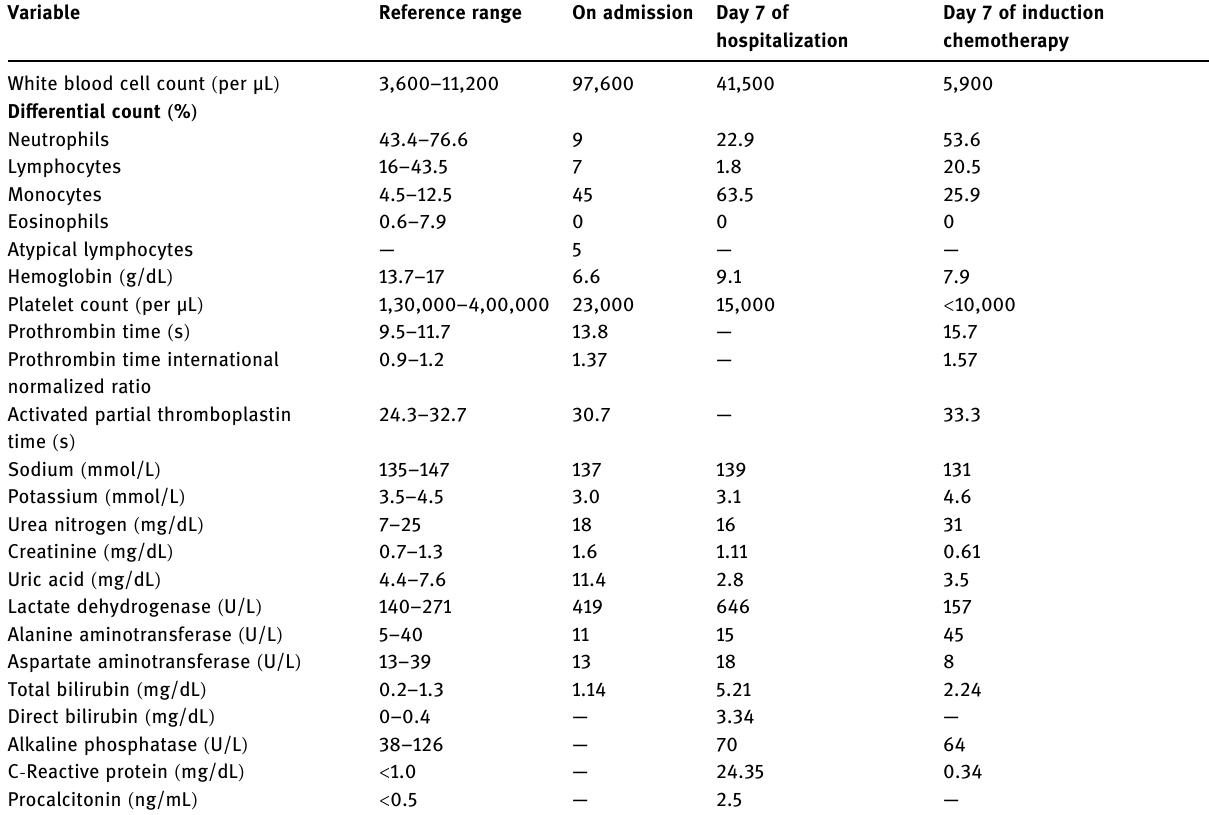
Table 1: Laboratory parameters